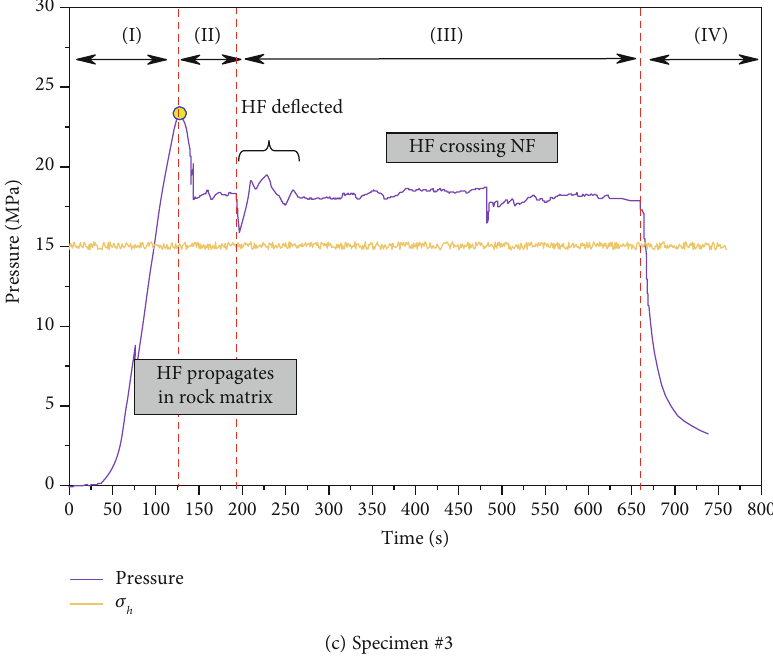
Figure 4: The injection pressure-time curves of each